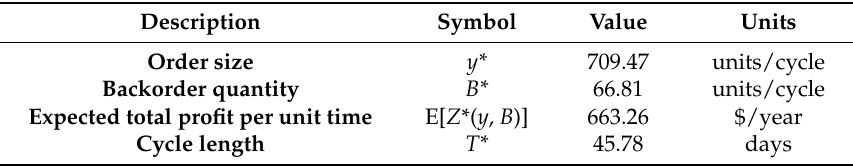
Table 5. Optimal values.